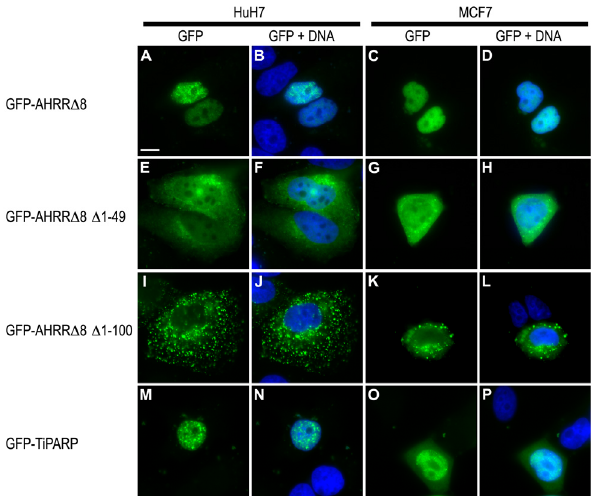
Figure 7. Sub-cellular localization of GFP-AHRR Δ 8, GFP-AHRR Δ 8 variants and GFP-TiPARP. GFP-AHRR Δ 8 (green) was localized in the nucleus (blue) of HuH7 and MCF7 cells ( A – D ); GFP-AHRR Δ 8_ Δ 1-49 was present in both the nucleus and the cytoplasm ( E – H ); while GFP-AHRRD8_ Δ 1-100 was localized predominantly in large foci in the cytoplasm ( I – L ); Wild-type GFP-TiPARP was localized in the nucleus in a pattern similar to that of GFP-AHRR Δ 8, although faint cytoplasmic expression was observed in MCF7 cells ( M – P ). Scale bar represents 10 mm ( A ); all panels were to same scale. Data